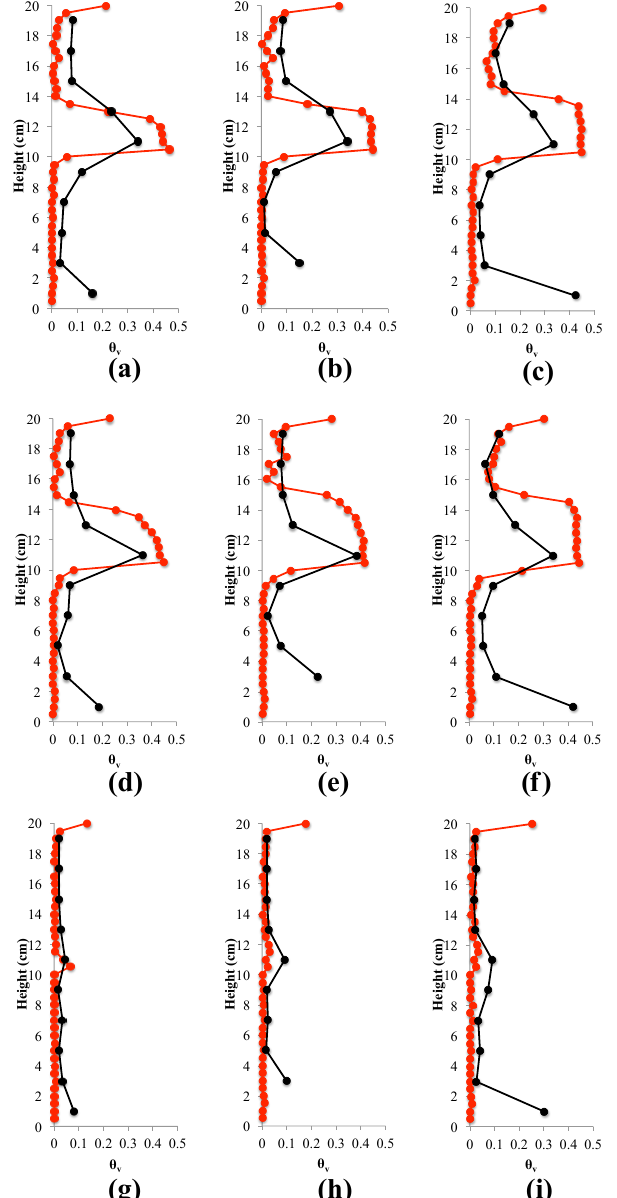
Figure 5. Profiles of volumetric water content for experiments (red line) and simulations (black line): (a) FC1, (b) FC2, (c) FC3, (d) FM1, (e) FM2, (f) FM3, (g) MC1, (h) MC2, and (i)